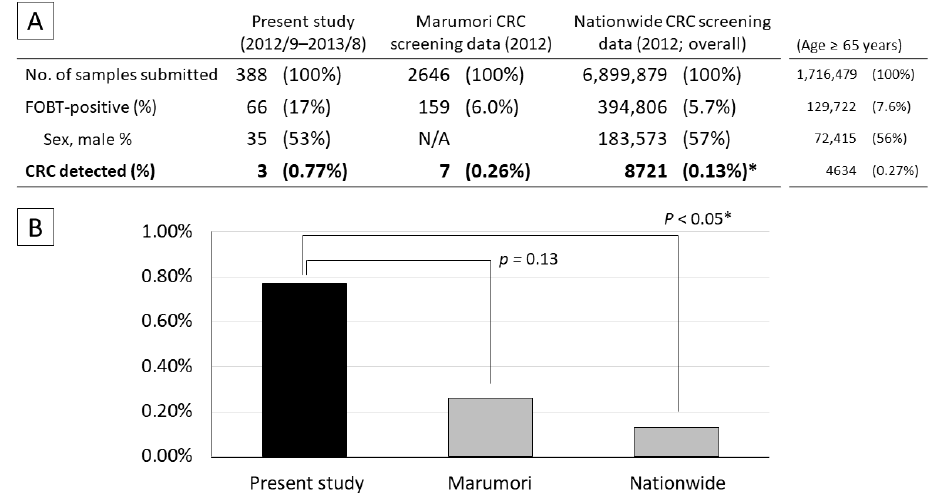
Figure 2. Comparison of CRC screening results in the present study with those of Marumori town and nationwide data. ( A ) Number of patients who submitted stool samples for FOBT and tested positive. ( B ) CRC detection rates. The data for Marumori and all of Japan were obtained from a cancer screening project; they do not include patients who did not undergo screening; therefore,